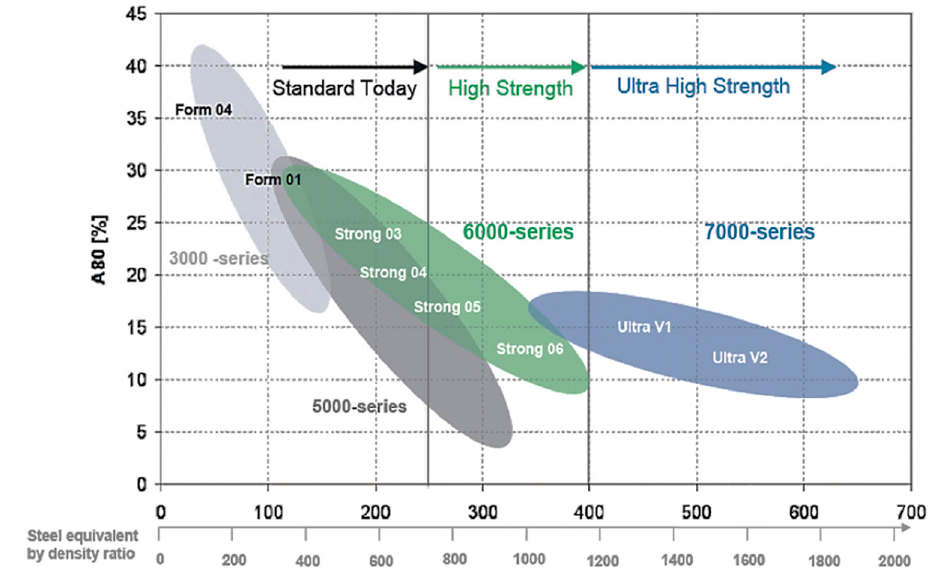
Figure 2. High strength aluminum sheets used for body structures in automotive industries [15] .